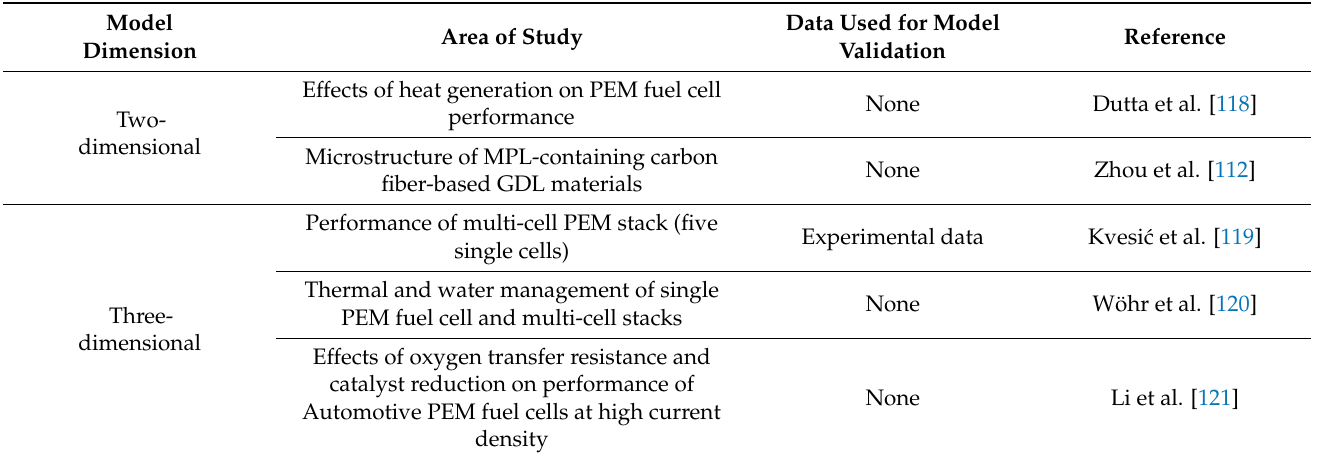
Table 3. Summary of PEM